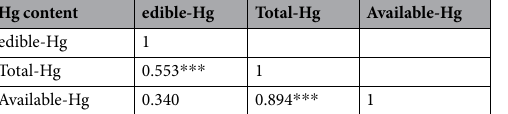
Table 2. Correlation coefficients between soil total Hg concentration, soil available Hg concentration and Hg concentrations in potato edible parts. *** p <